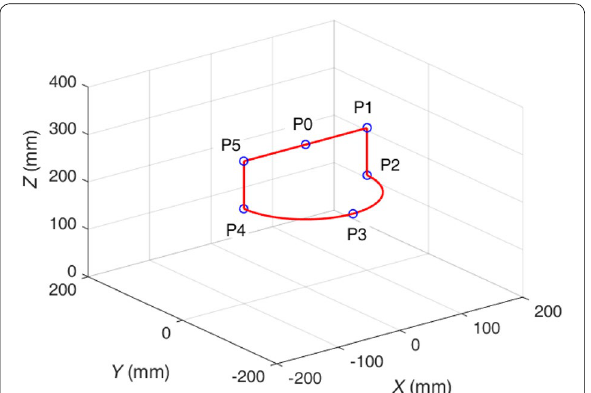
Figure 3 Given trajectory of the end-effector